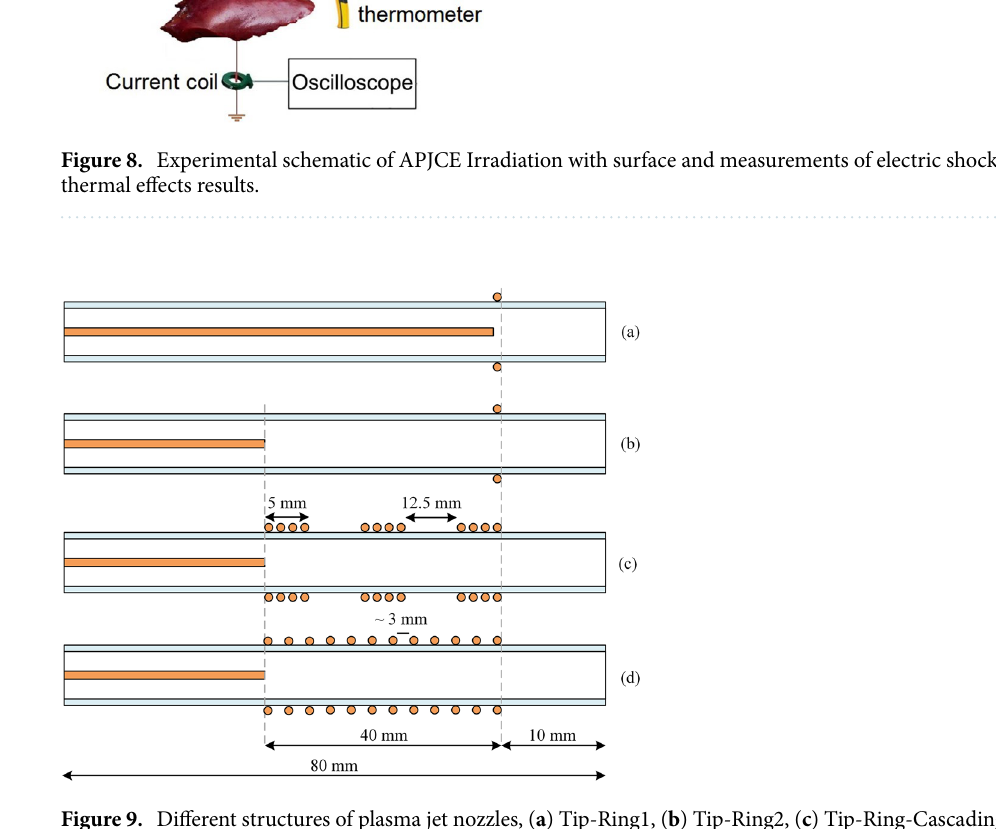
Figure 9. Different structures of plasma jet nozzles, ( a ) Tip-Ring1, ( b ) Tip-Ring2, ( c ) Tip-Ring-Cascading1, ( d )